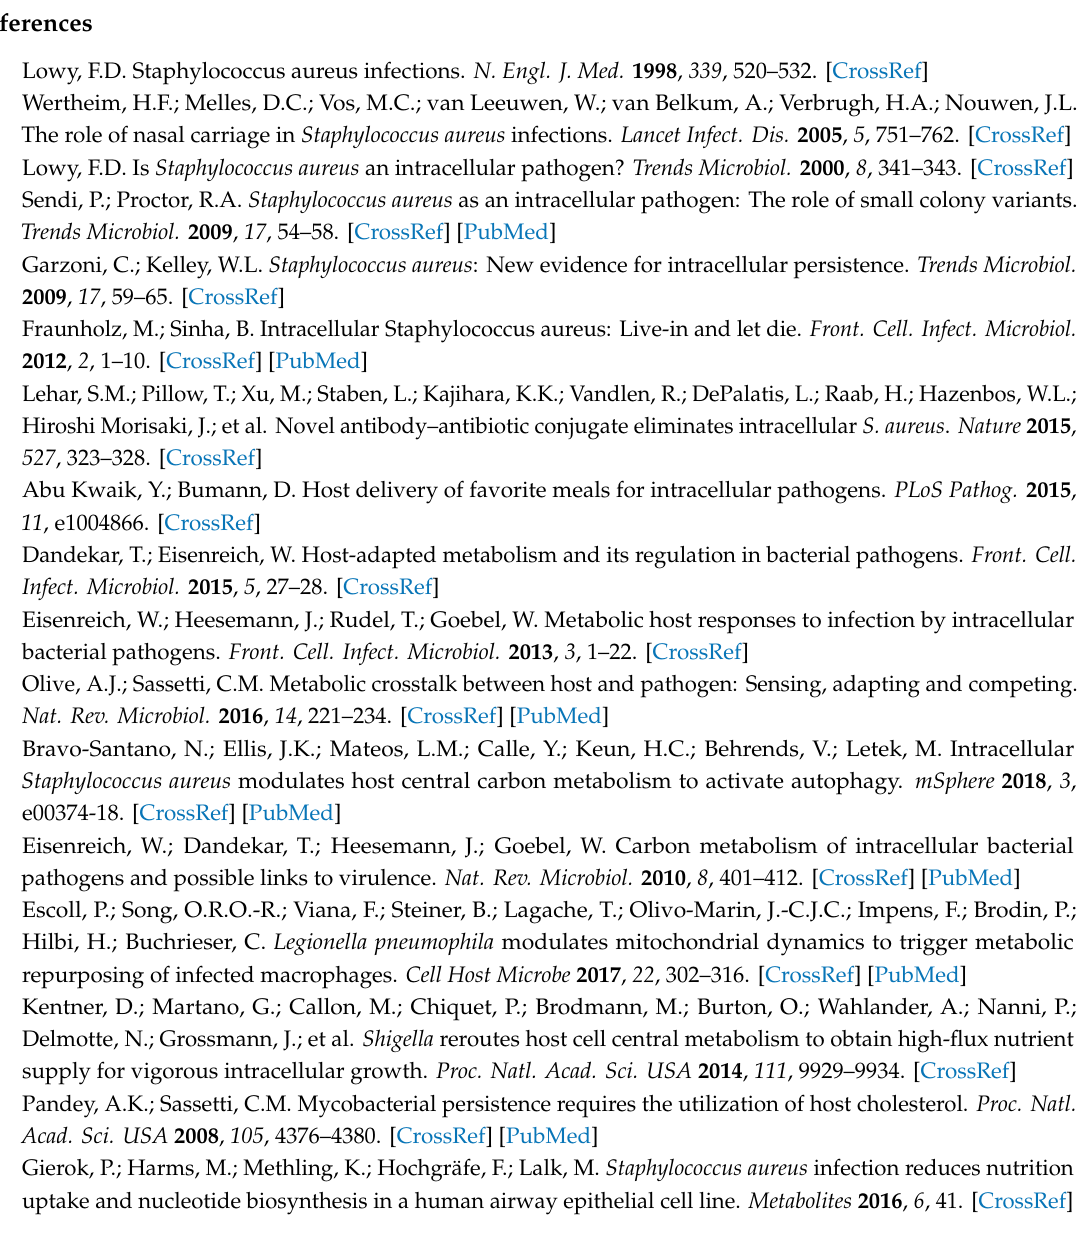
Figure S1: Absolute levels of arachidonic, linoleic, myristic, oleic and palmitoleic acids after intracellular USA300 infection, Figure S2: Labelling distribution of arachidonic, linoleic, myristic, oleic and palmitoleic acids after intracellular USA300 infection, Figure S3: Isotopologue distribution of eicosanoic